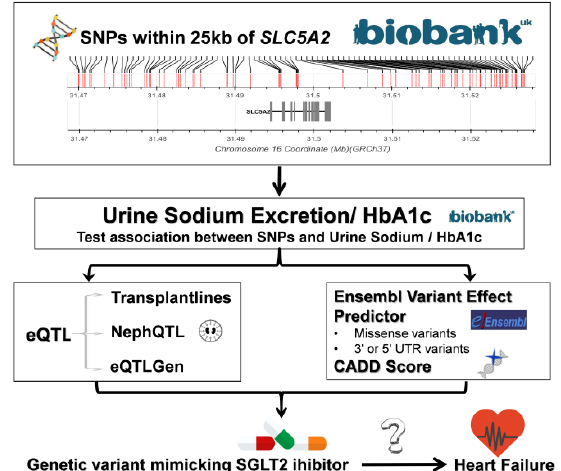
Figure 1. Study design.